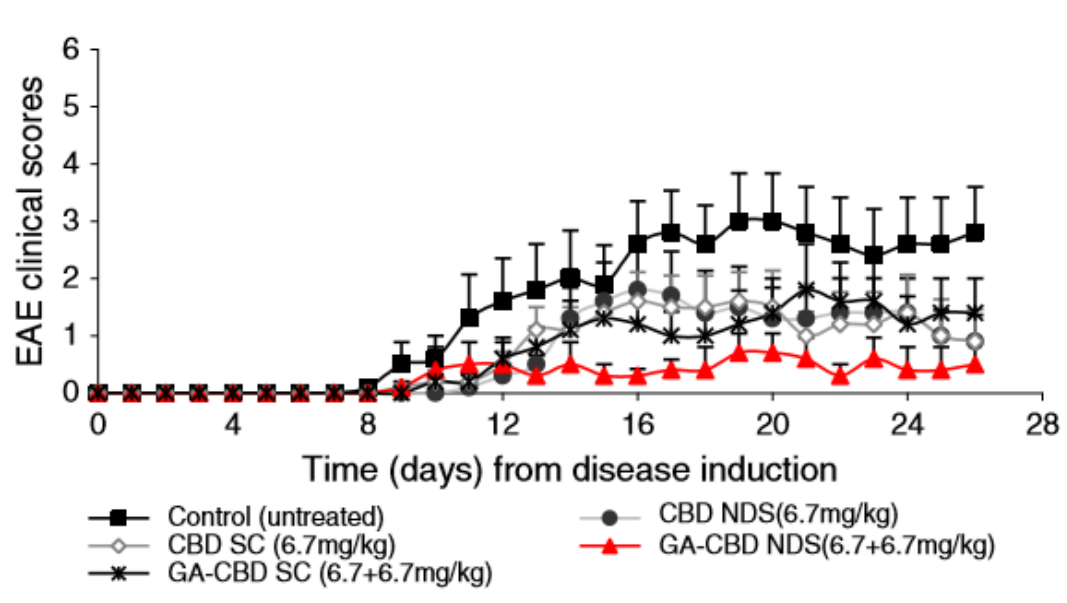
Figure 10. Mean clinical scores (mean ± SE) in EAE mice that received 6.7 mg / kg / days CBD alone or in combination with 6.7 mg / kg / day GA nasally from a nasal nanovesicular carrier (NDS) or subcutaneously, starting from the first day of the clinical manifestation of the disease. Reproduced from Reference [151] with permission.